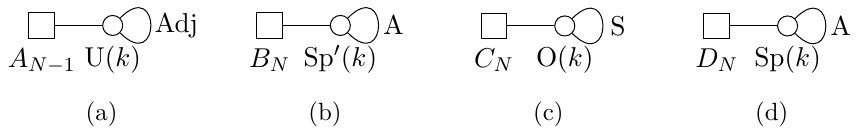
Figure 2. ADHM quivers whose Higgs branch is M k,G . A denotes the 2nd antisymmetric, and S the 2nd symmetric of the fundamental representation (these are not irreducible as they include singlets). We have: (a) G = SU( N ) , (b) G = SO(2 N + 1) , (c) G = Sp( N ) , (d) G = SO(2 N ) . It is essential that the gauge group in (c) is O ( k ) and not SO ( k )